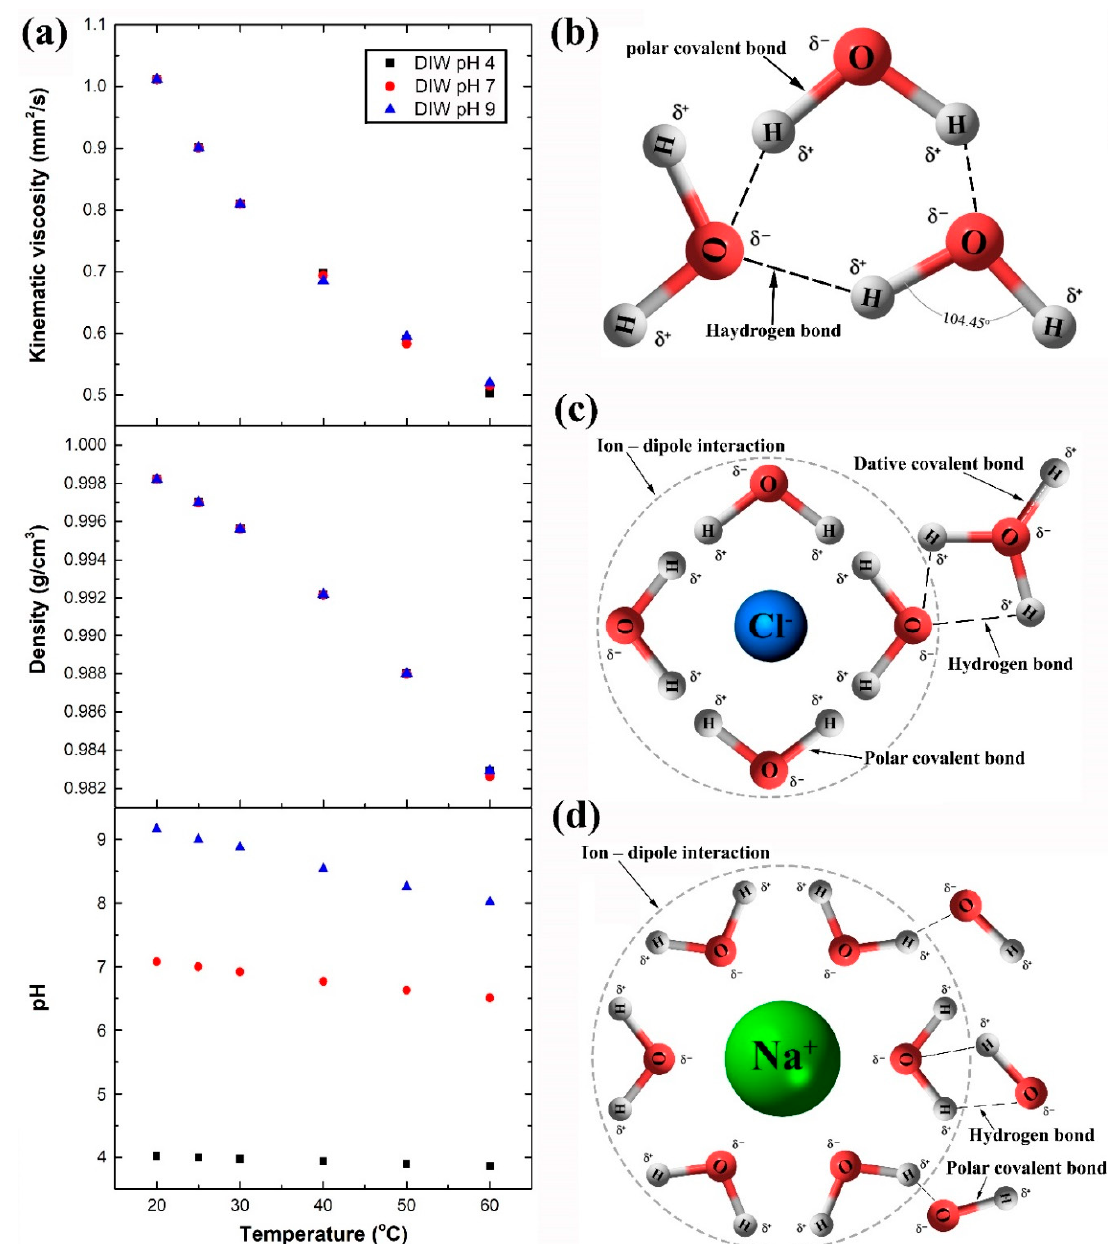
Figure 8. Water atoms and molecules bonds, and properties variation with temperature, where ( a ) shows the DIW’s kinematic viscosity, density, and pH value changes with temperature, and ( b – d ) illustrates the bonds in water of pH 7, 4, and 9, respectively.